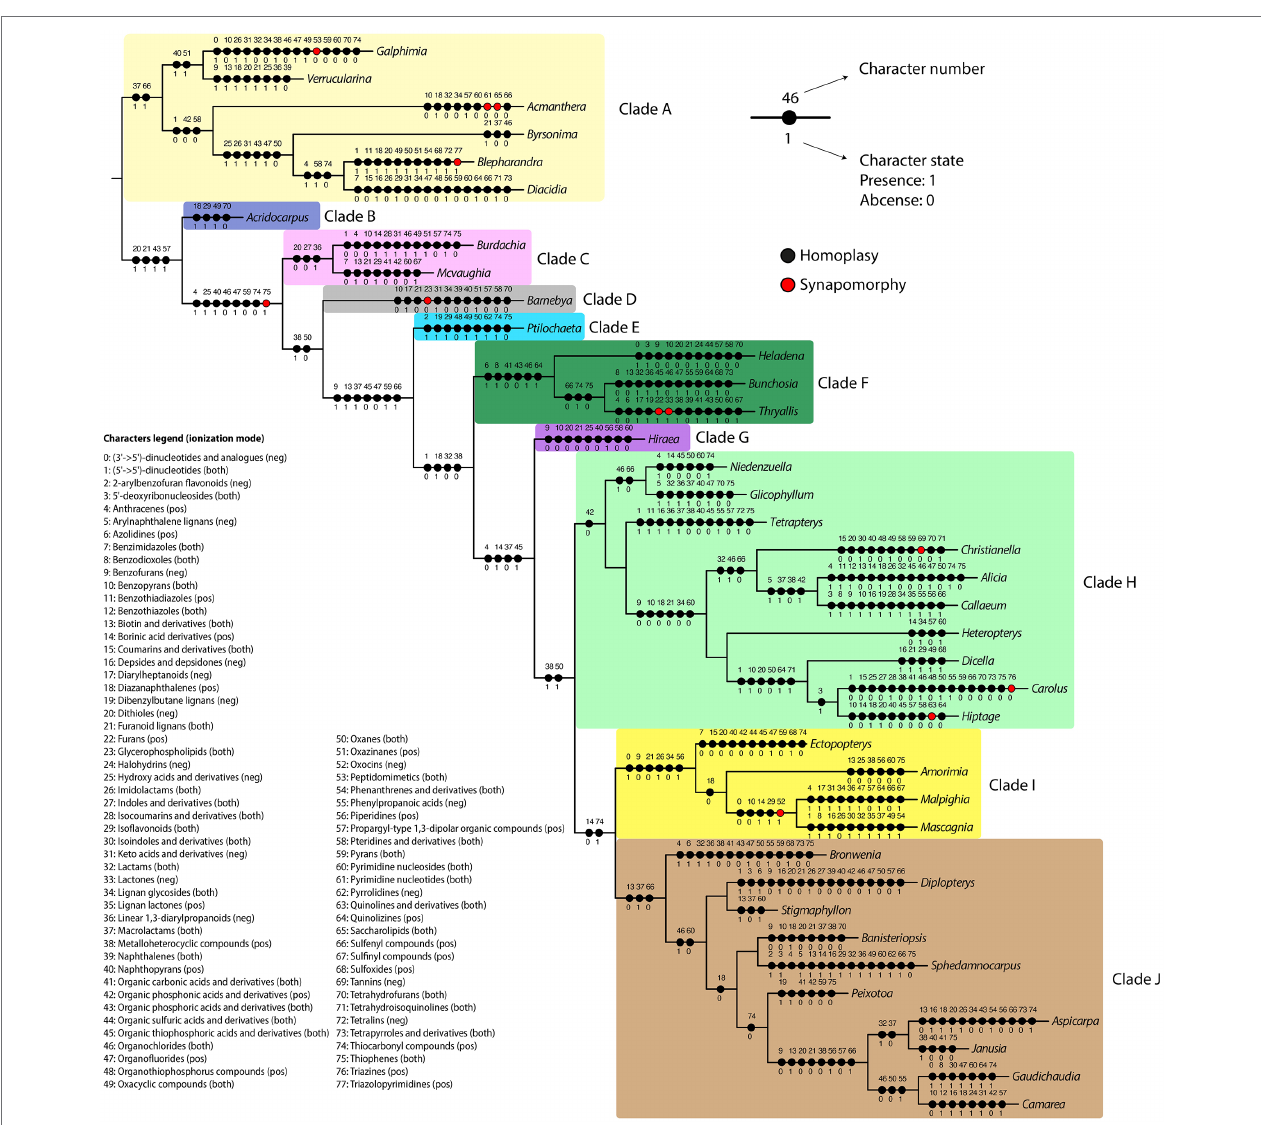
FIGURE 6 | Summary of the maximum likelihood ancestral state reconstruction for the in silico classifications obtained at a class level. Each chemical class was treated as a character (0–77), and character states were binary-coded for each genus (1: present; 0: absent). Black and red circles represent homoplasies and synapomorphies, respectively. Clades highlighted represent the Malpighiaceae major clades recognized by recent molecular phylogenetic studies according to Davis and Anderson